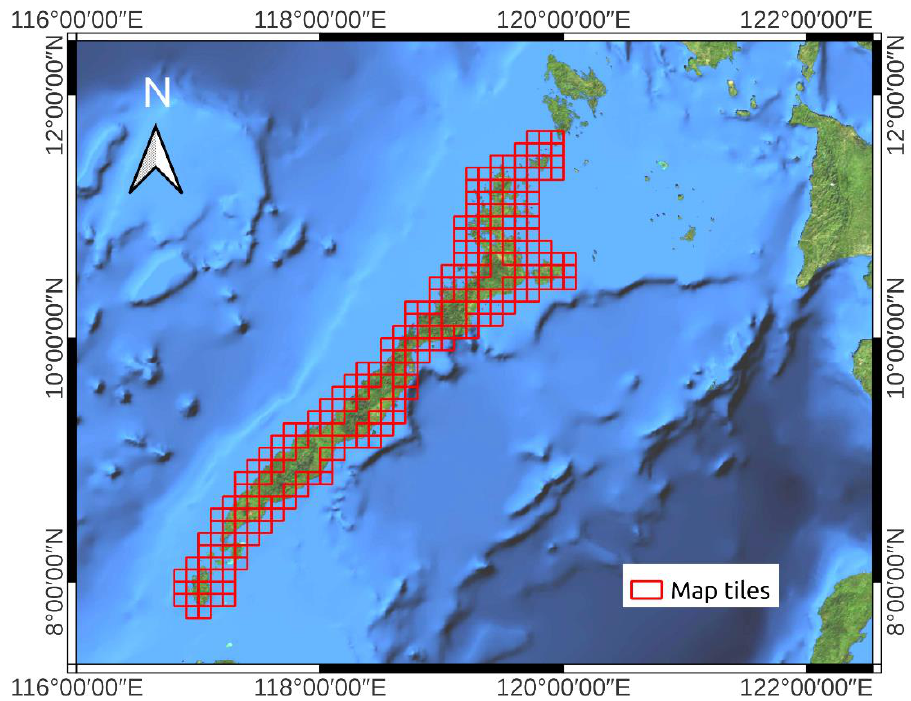
Figure 2. The map of the study area in Palawan, Philippines. It was divided into tiles of 0.1 degrees in latitude and longitude shown in red.